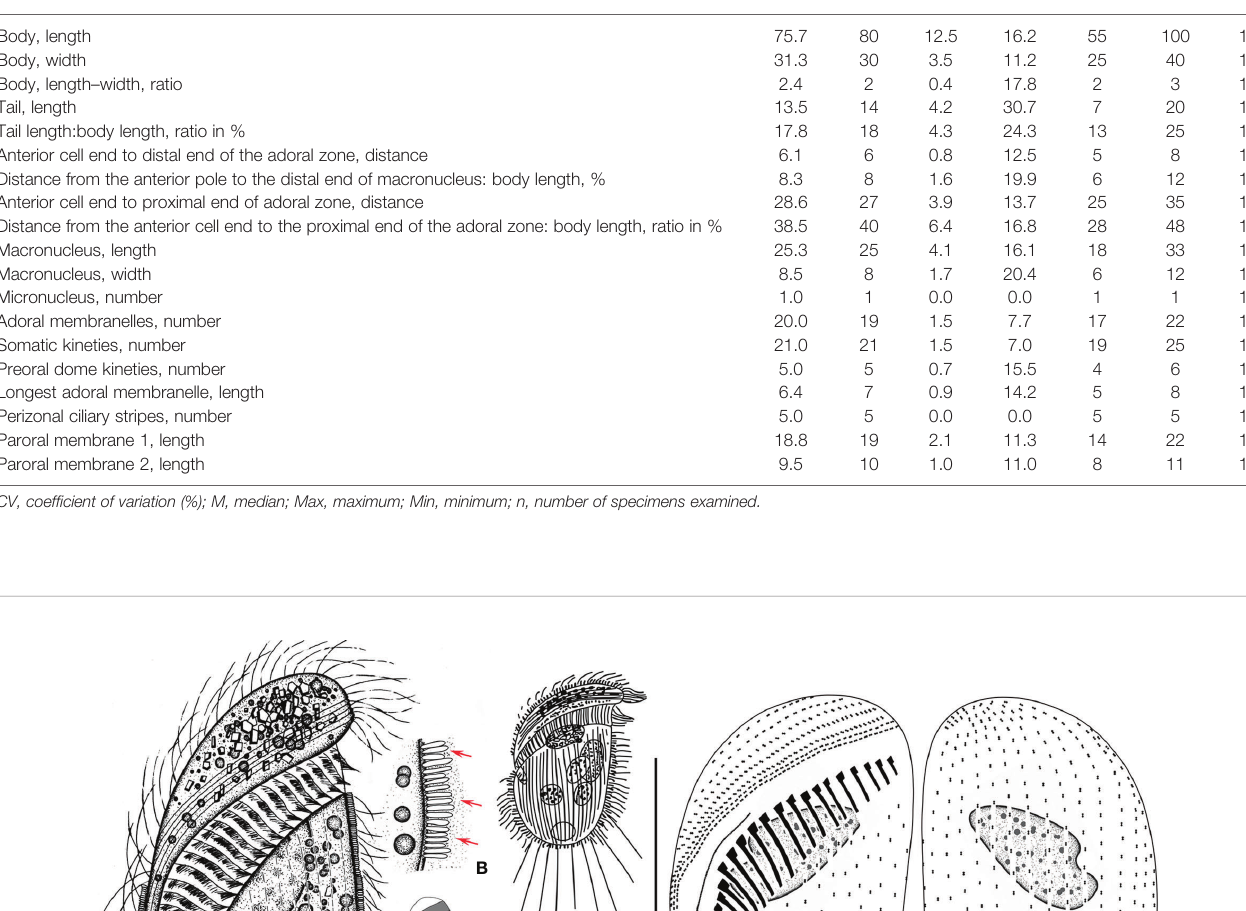
TABLE 2 | Morphometric characteristics of Metopus spiculatus sp. n. based on protargol-stained specimens. Measurements in m m. Characteristics